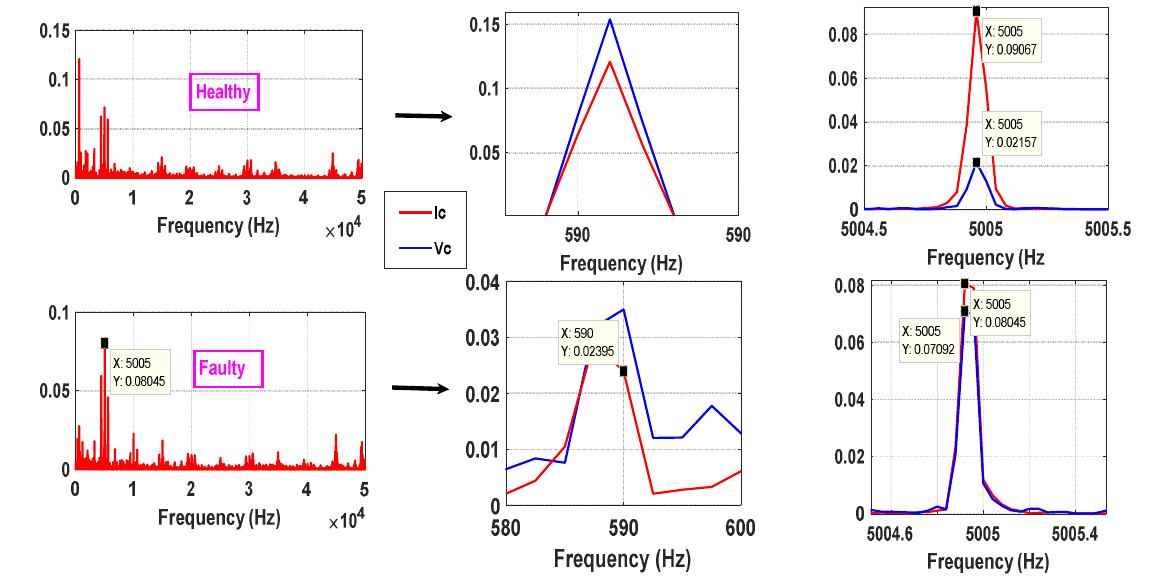
Figure 10. Cap1 and Cap2 voltage in healthy and faulty states.